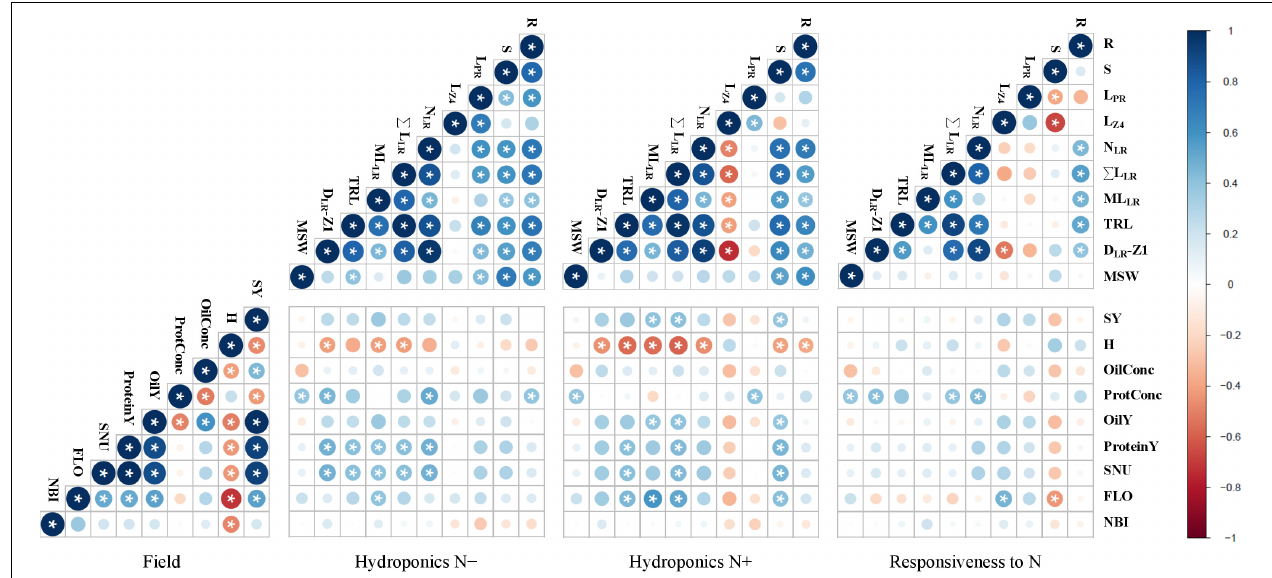
FIGURE 5 | Inter-trait phenotypic correlations in winter oilseed rape genotypes. Biomass production and root morphological traits were measured at 0.2 mM nitrate (N–) or 5 mM nitrate (N+) in hydroponics. Seed yield and seed quality traits as well as optical indices were measured in the field. Circle area and color intensity indicate the strength of the Pearson’s correlation. Blue or red colors indicate positive or negative correlations. Star indicates a correlation coefficient significantly ( P < 0.05) different from zero. Traits are defined in Tables 1 , 2